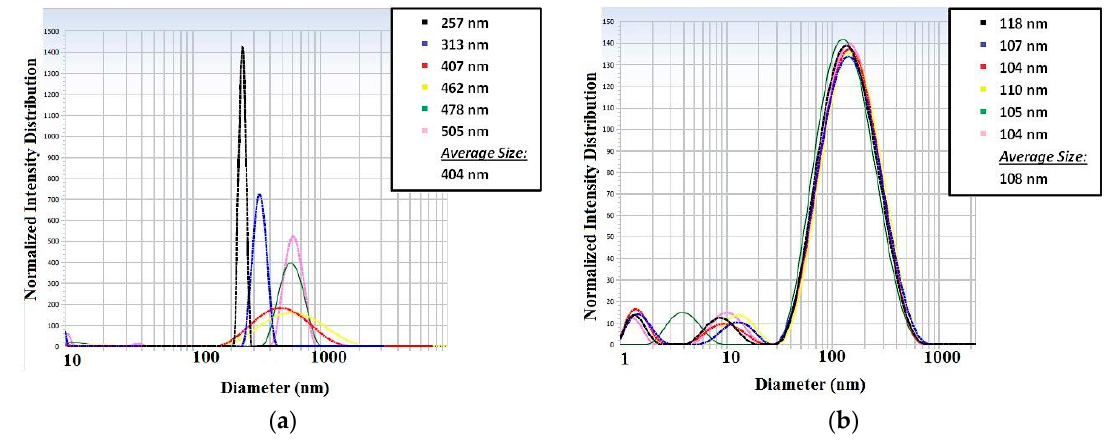
Figure 10. Particle sizes measurements: ( a ) results obtained for a solution with 5% of surfactant and ( b ) results obtained for a solution with 10% of surfactant.